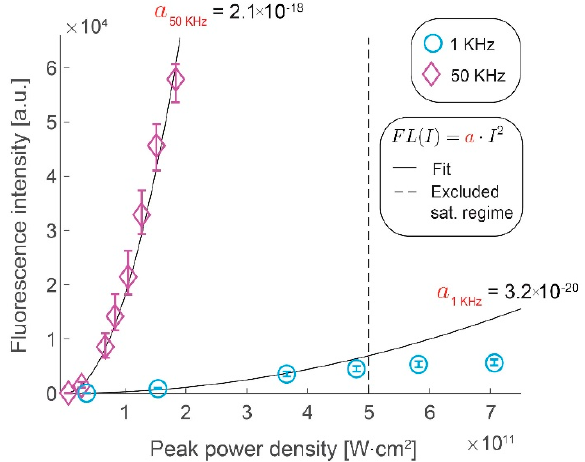
Figure 2. Gains in fluorescence intensity with increased pulse repetition rate. Fluorescence intensity increases with the peak power density of excitation light shown for 1 kHz (circles) and 50 kHz (diamonds). Quadratic fits with a single coefficient are shown as black lines (1 kHz, R 2 = 0.97, 50 kHz, R 2 = 0.99). Data points beyond a saturating peak power density value were excluded from the fit. Error bars represent bootstrapped confidence intervals for the mean fluorescence intensities calculated at α = 0.01 confidence level. Data derived from n = 117 (1 kHz) and n = 41 (50 kHz) measurements of fluorescent microspheres, within 10% of the area around the excitation beam maximum.